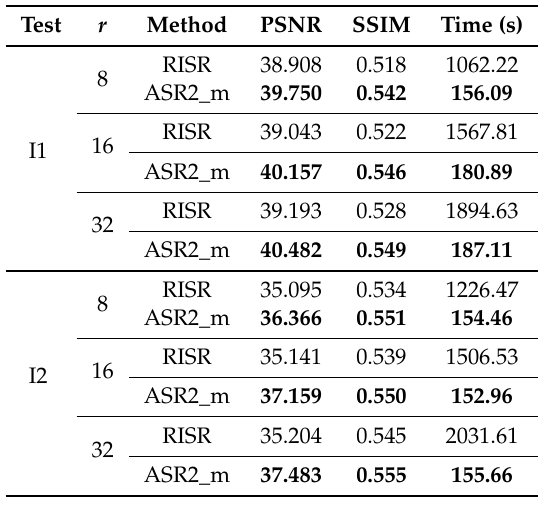
Table 2. Comparison of the ASR2_m and RISR methods in the case of MISR when choosing a different number of input images r . In bold we highlight the best